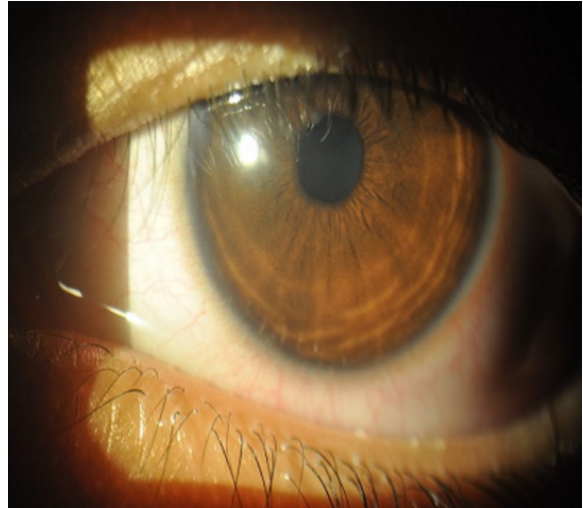
Figure 6: Slit lamp photo after